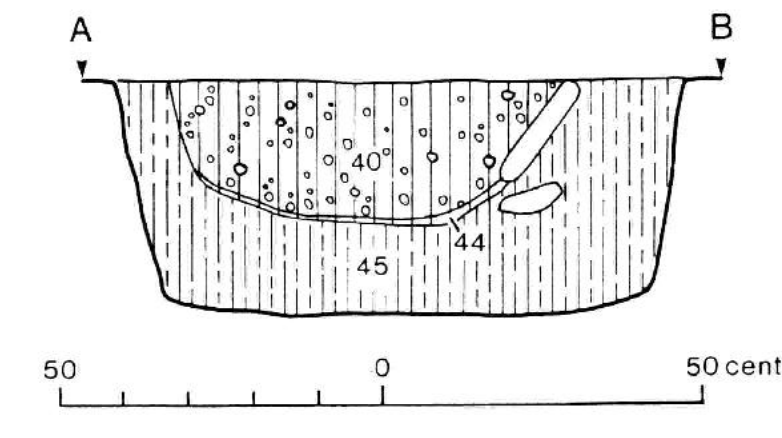
Figure 3: section across pit F41 from the north-west